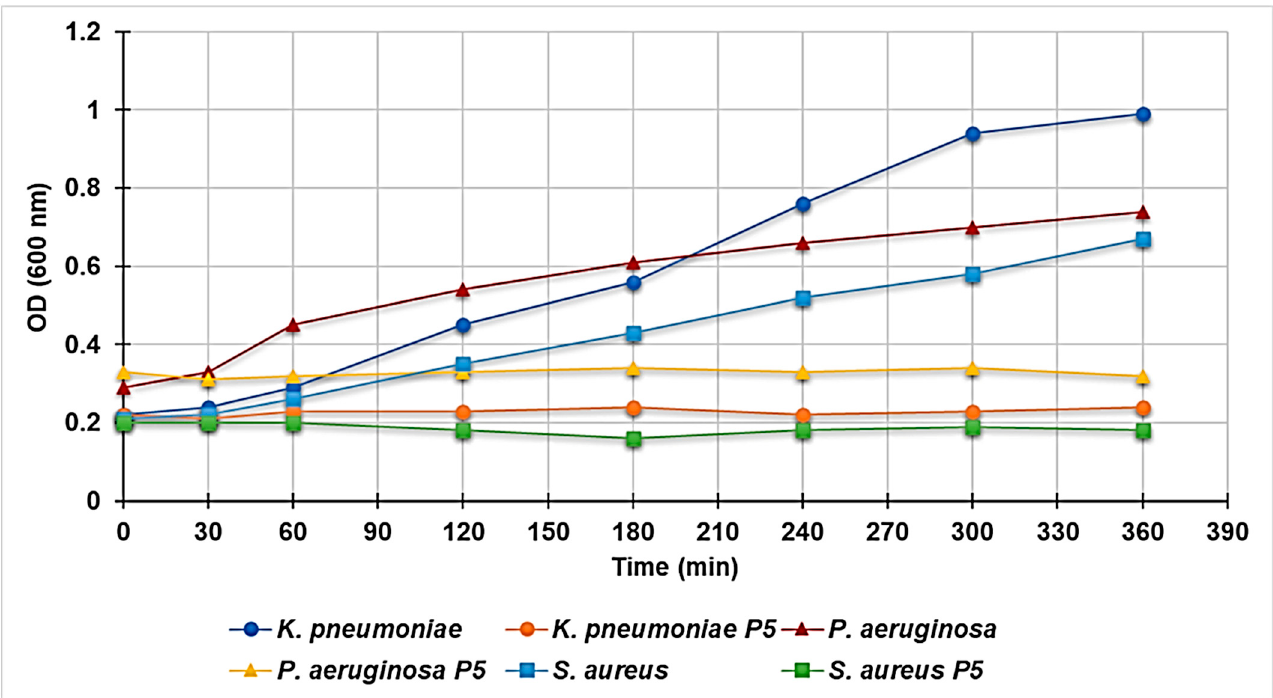
Figure 5. Effect of P5 (at 4 × MIC) on the growth curve of K. pneumoniae (strain 466), S. aureus (strain 18) and P. aeruginosae followed at 600 nm for a period of 6 h.